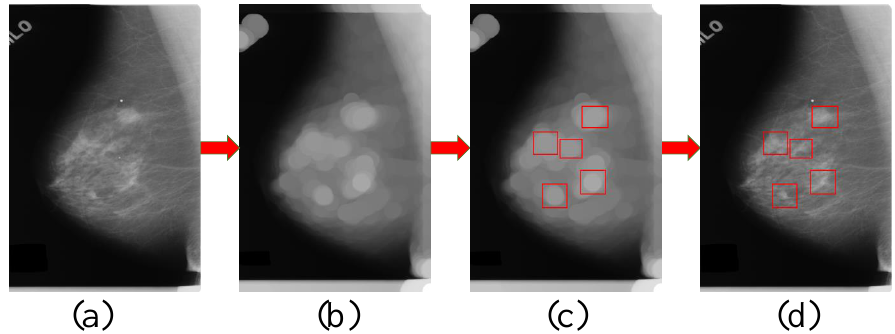
Figure 8. Process of candidate region generation for breast mass in a mammographic image by the mathematical morphology method and image template matching method. ( a ) is a mammo- graphic image, and ( b ) is the processed image using the mathematical morphology method, ( c , d ) show the matched suspected regions of breast mass on the processed image and mammographic image,